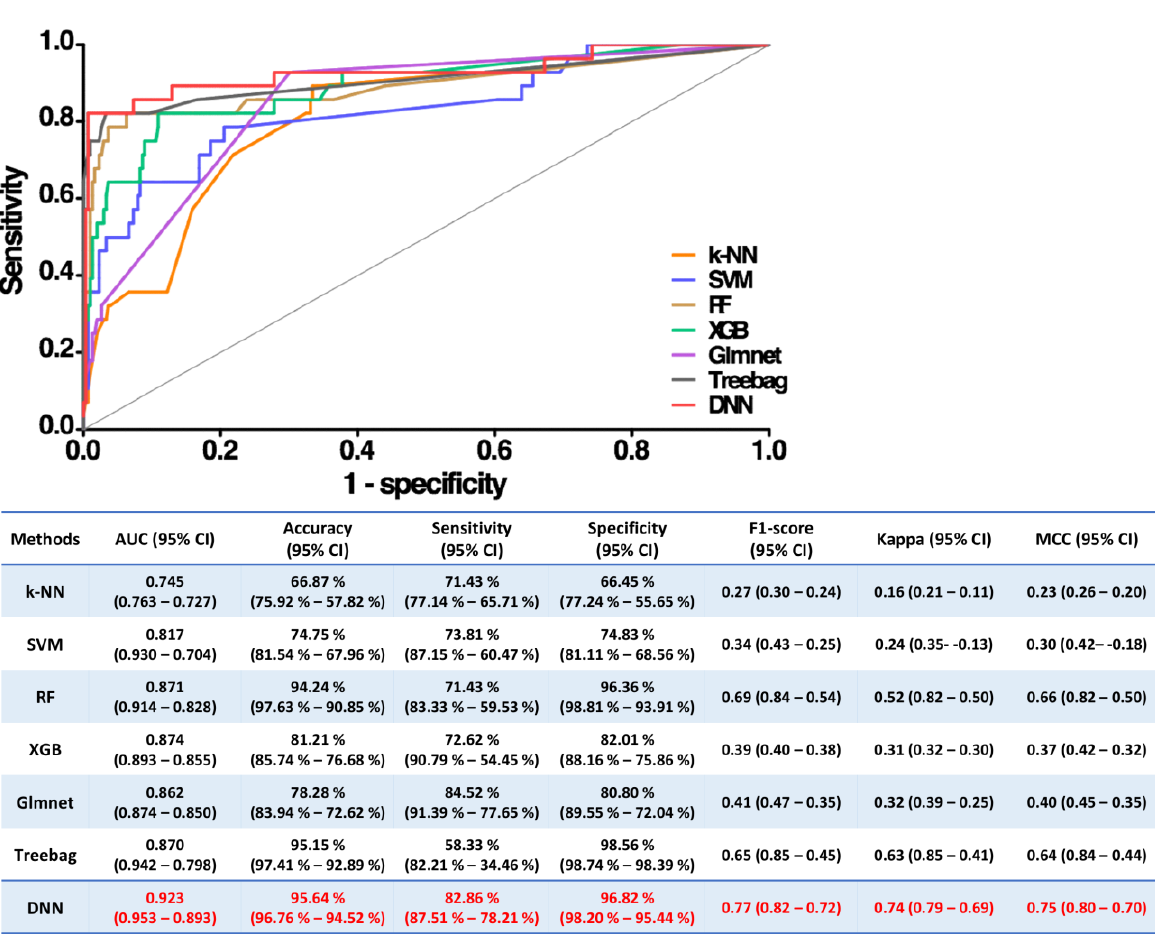
Figure 4. Comparison of AUCs among machine learning models. DNN yielded the greatest AUC for single-model prediction. The bar graph indicates the median value of the AUC of each model. K-NN: k-nearest neighbors algorithm; RF: random forest; SVM: support vector machine; DNN: deep neural networks; XGB: eXtreme gradient boosting; Treebag: regression tree algorithm; red color indicates the best performance.